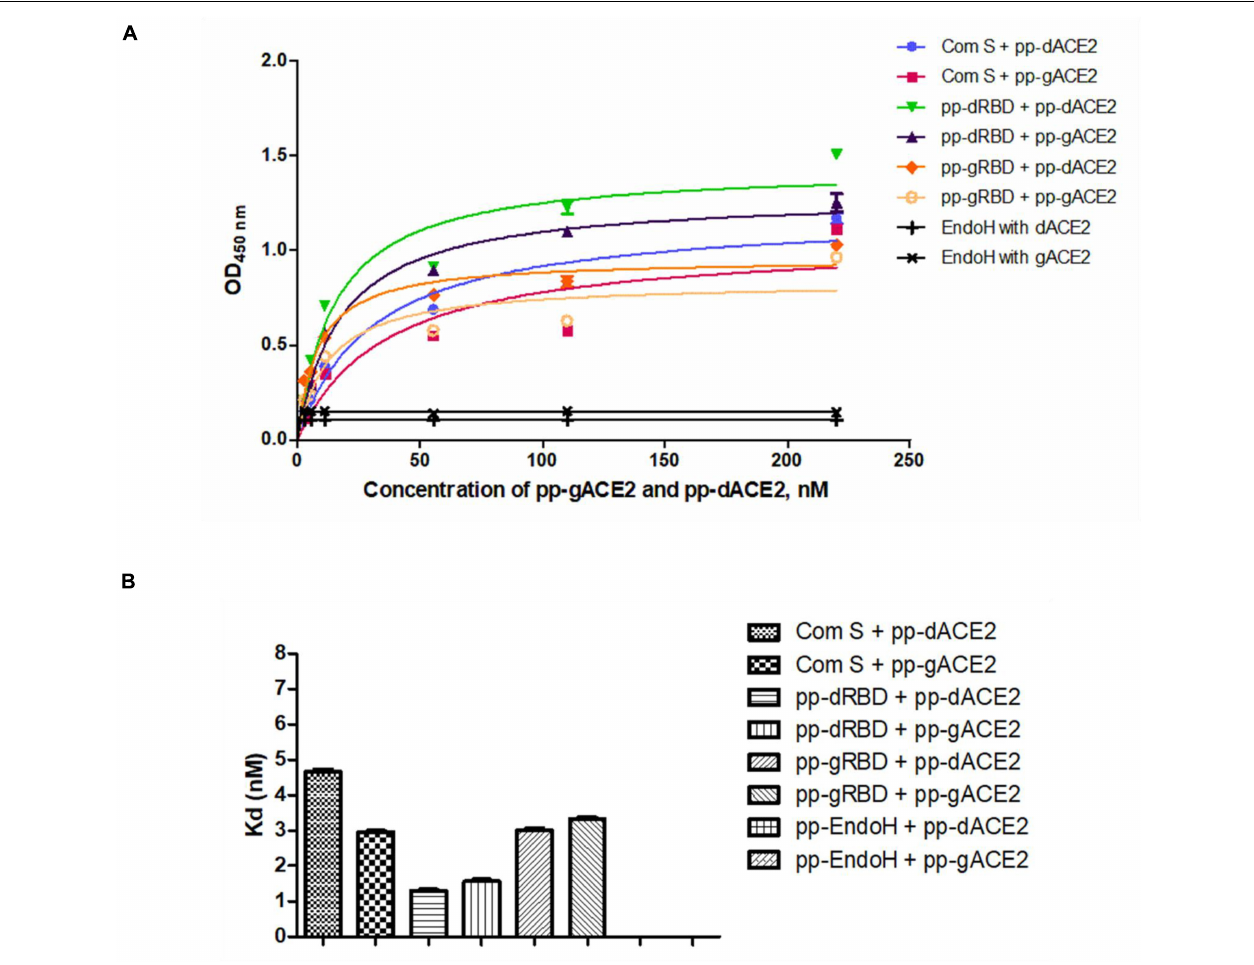
FIGURE 4 | Binding activity of plant produced glycosylated or deglycosylated variants of ACE2 with commercial or plant produced, glycosylated or deglycosylated forms of spike proteins (Flag tagged). Commercial or plant-produced spike protein was coated with an ELISA plate at a concentration of 200 ng/well. Different concentration of plant produced, Sephacryl R (cid:13) S-200 HR column purified, gACE2 or dACE2 proteins (His-tagged) were added. Purified anti-human monoclonal ACE2 antibody (Cat. No. 375801, BioLegend) was used as a primary and rat IgG used as secondary antibodies. Com S: commercial Spike protein, active Recombinant 2019-nCoV Spike Protein, RBD, His Tag, produced in Baculovirus-Insect Cells, Cat. no. MBS2563882); pp-gRBD: plant produced glycosylated Receptor Binding Domain of Spike protein (Mamedov et al., 2021); pp-dRBD: plant produced deglycosylated RBD (Mamedov et al., 2021); pp-gACE2: plant produced gACE2; pp-dACE2: plant produced Endo H in vivo dACE2; Endo H, plant produced Flag-tagged protein was used as negative control. (A,B) Graph for binding affinity between pp-gACE2 and pp-dACE2 to spike protein variants. (A) A graph was plotted with non-linear regression analysis in GraphPad software. Points refer to absorbance for each sample dilutions and lines were plotted according to Kd value. (B) Column bar graph of Kd values determined with non-linear regression analysis in GraphPad